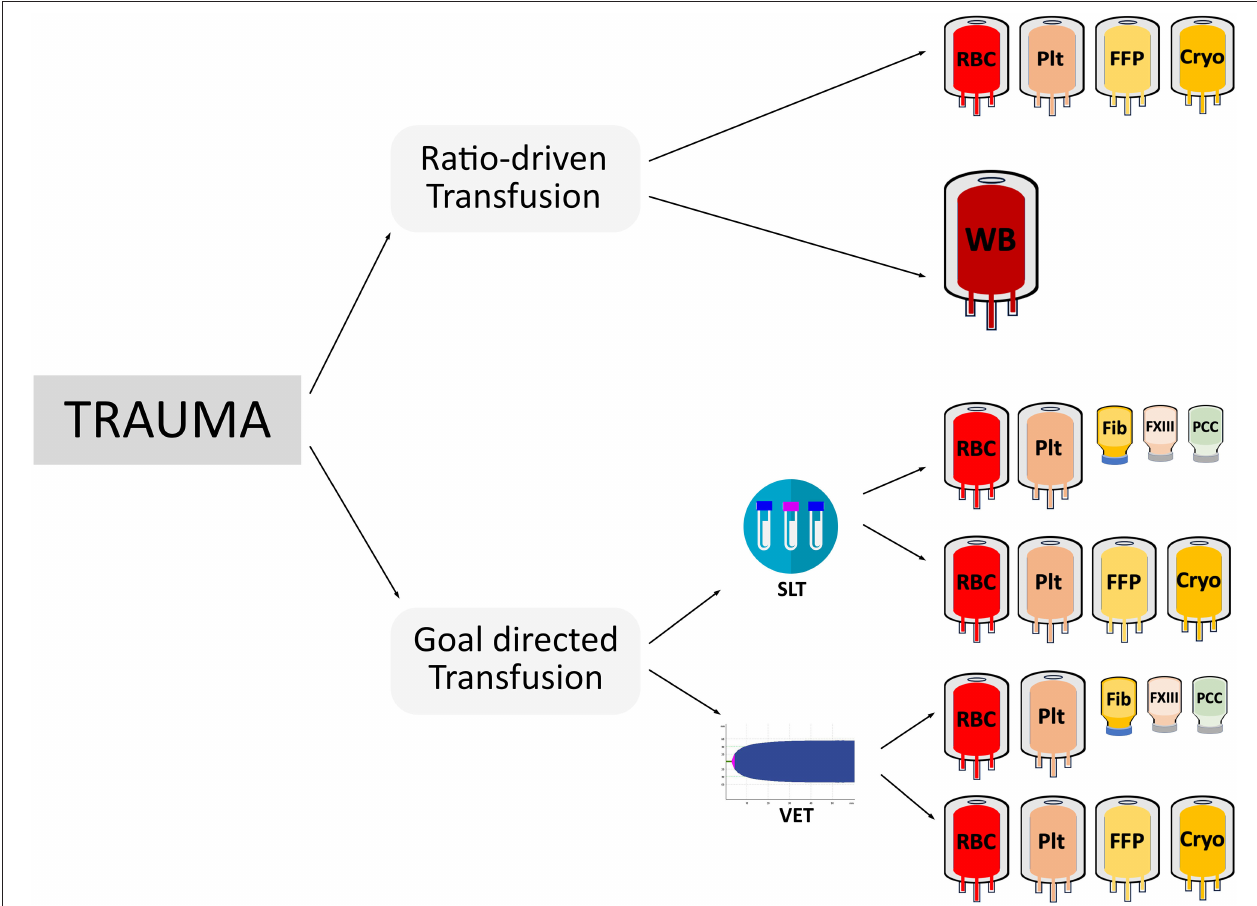
FIGURE 1 | This figure illustrates the various potential treatment options for acutely bleeding trauma patients depicting the considerable differences in coagulation testing (SLT, standard laboratory testing; VET, viscoelastic testing), treatment options (ratio-driven vs. goal-directed transfusion), blood components (RBC, red